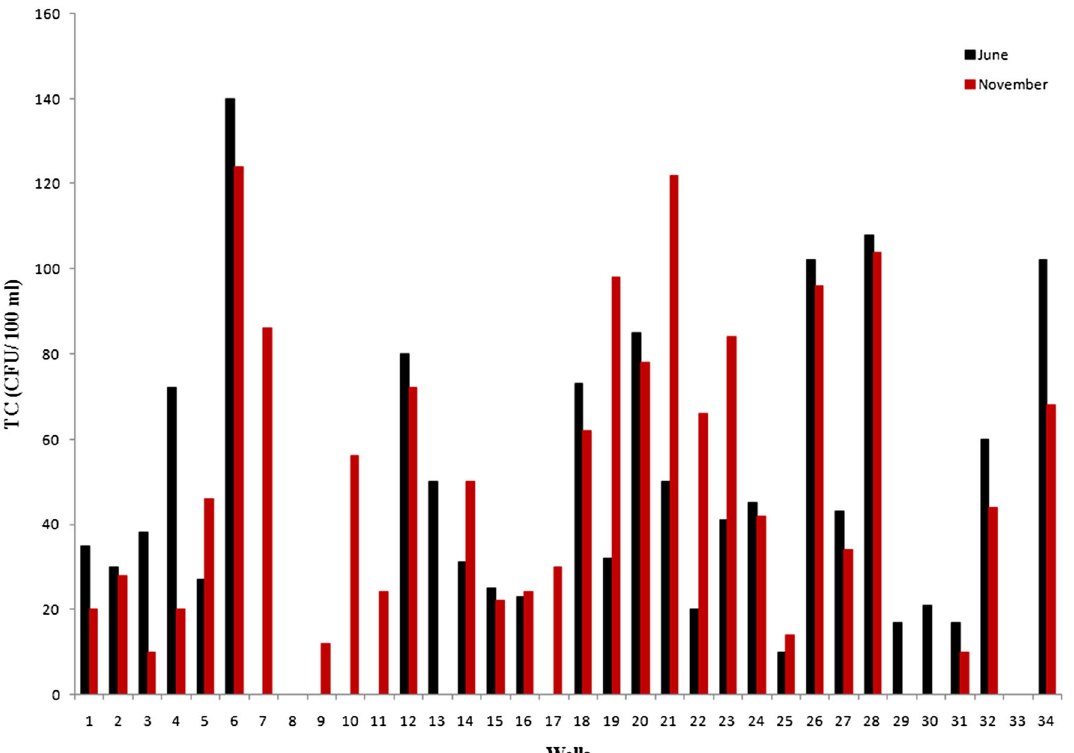
Fig. 2 Abundance of TC in groundwater ( vertical axis ), as sampled in June and November 2013 ( horizontal axis )